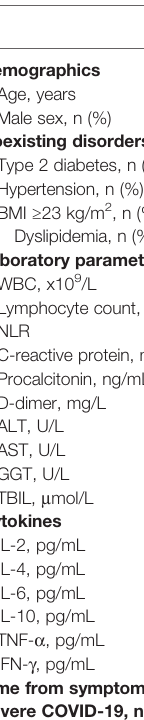
TABLE 1 | Baseline characteristics of COVID-19 patients, strati fi ed by MAFLD status at hospital admission.